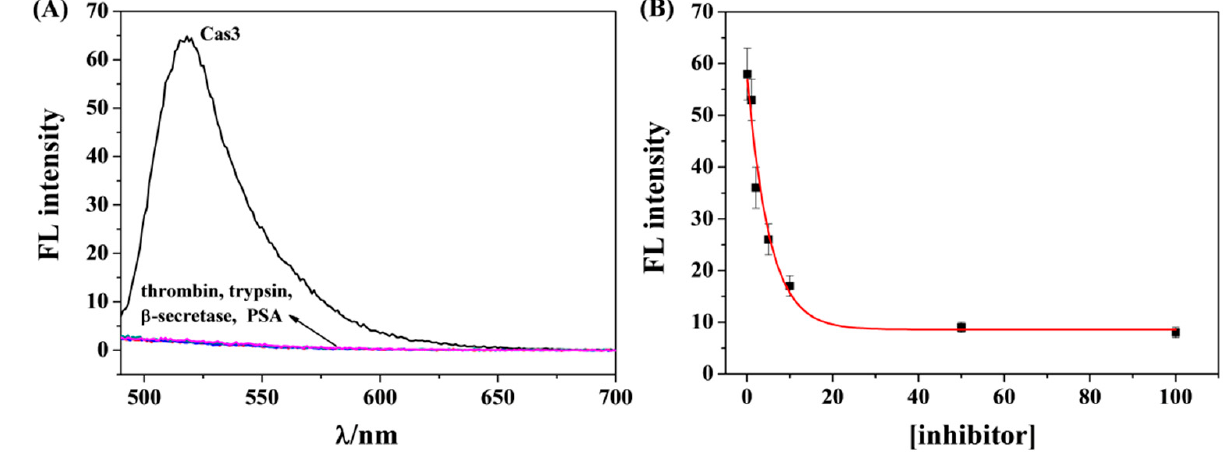
Figure 4. ( A ) Selectivity of this method toward 20 ng/mL Cas, thrombin, trypsin, β -secretase and PSA. ( B ) Dependence of fluorescence intensity on inhibitor concentration.